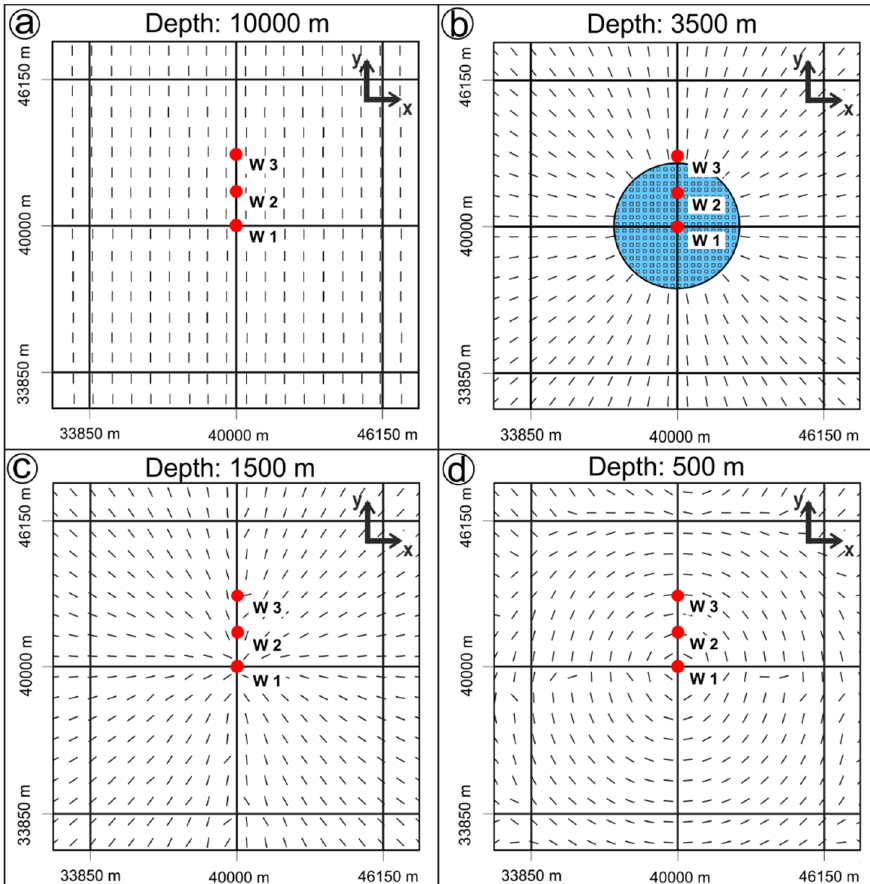
Figure 6 . Four horizontal sections through the central part of Model B-04c showing the orientation of S Hmax . ( a ) at 10000 m depth, below the salt; ( b ) at 3500 m depth at about the middle of the salt diapir marked by the blue circular cross section; ( c ) at 1500 m depth right above the top of the salt diapir; and ( d ) at 500 m depth. Shortening amounts to 200 m and is applied to the subsalt (below 5000 m) in y-direction. Salt viscosity is 10 18 Pa·s.